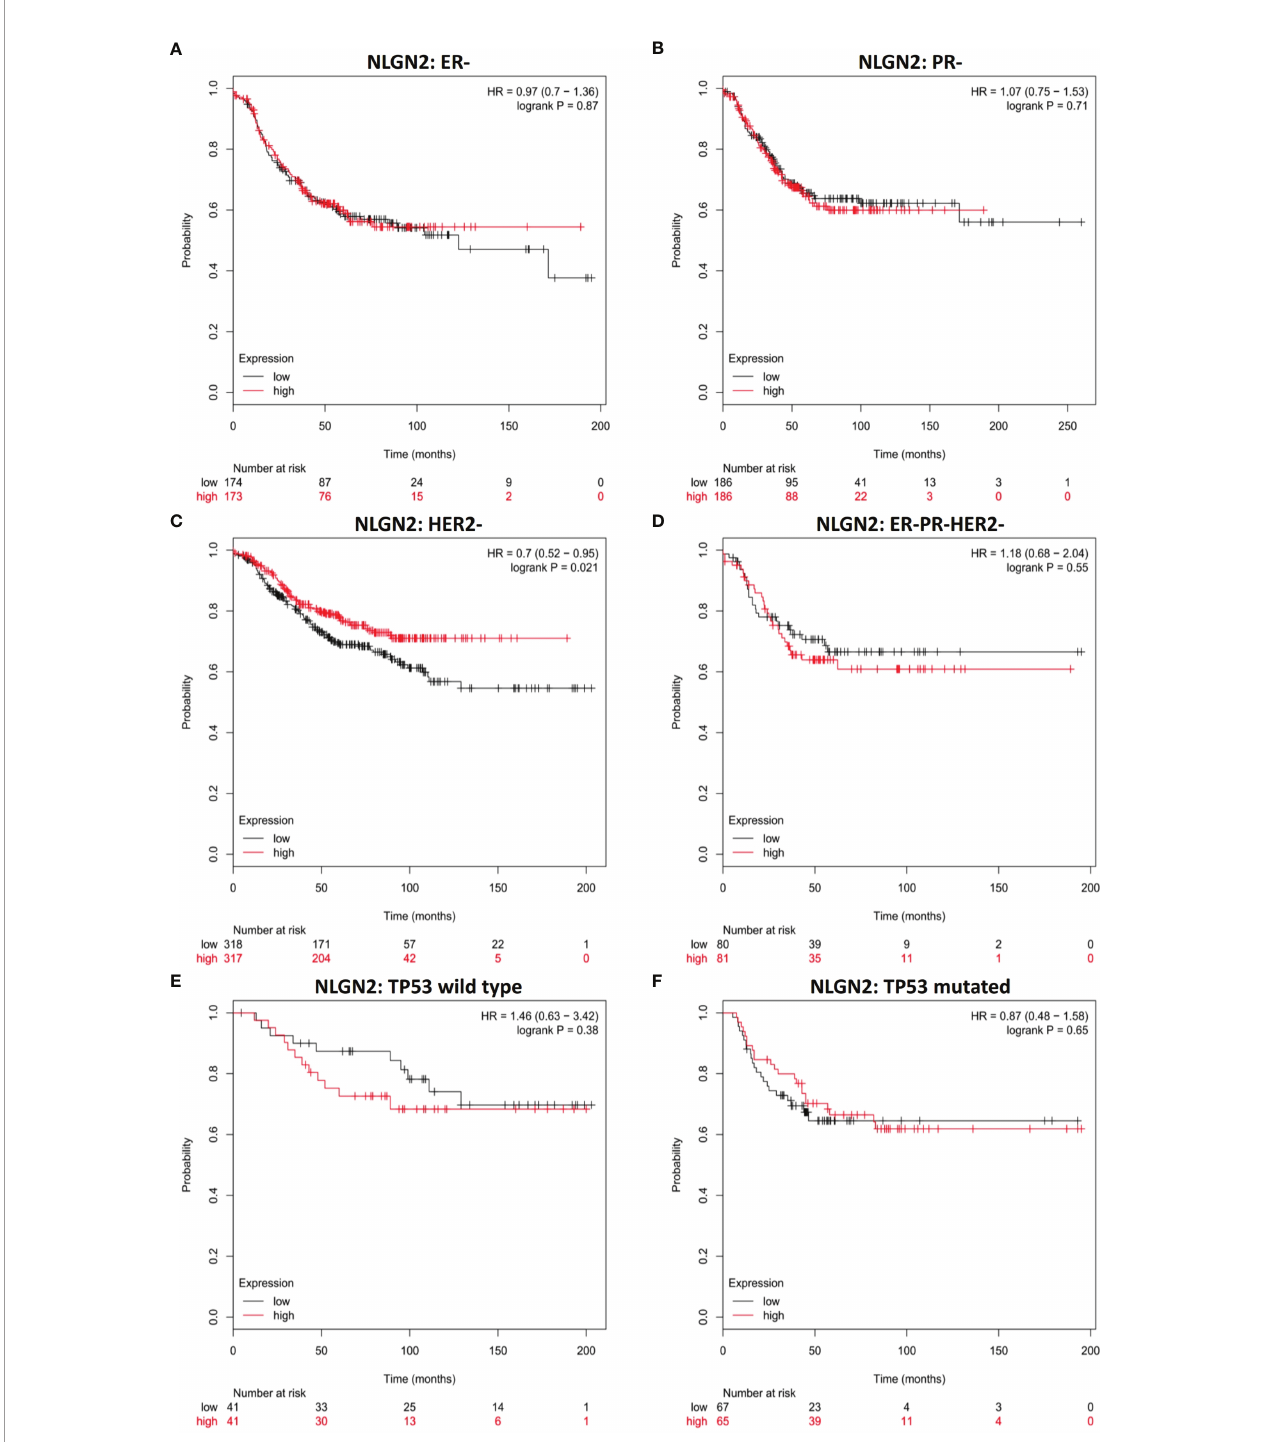
FIGURE 2 | NLGN2 is favorable for HER2- breast cancer patients. (A) Prognostic analysis of NLGN2 in ER- breast cancer. (B) Prognostic analysis of NLGN2 in PR- breast cancer. (C) Prognostic analysis of NLGN2 in HER2- breast cancer. (D) Prognostic analysis of NLGN2 in ER-/PR-/HER2- breast cancer. (E) Prognostic analysis of NLGN2 in TP53 wild type breast cancer. (F) Prognostic analysis of NLGN2 in TP53 mutated breast cancer. The HR and log rank p values are indicated in each panel, and p < 0.05 is statistically signi fi